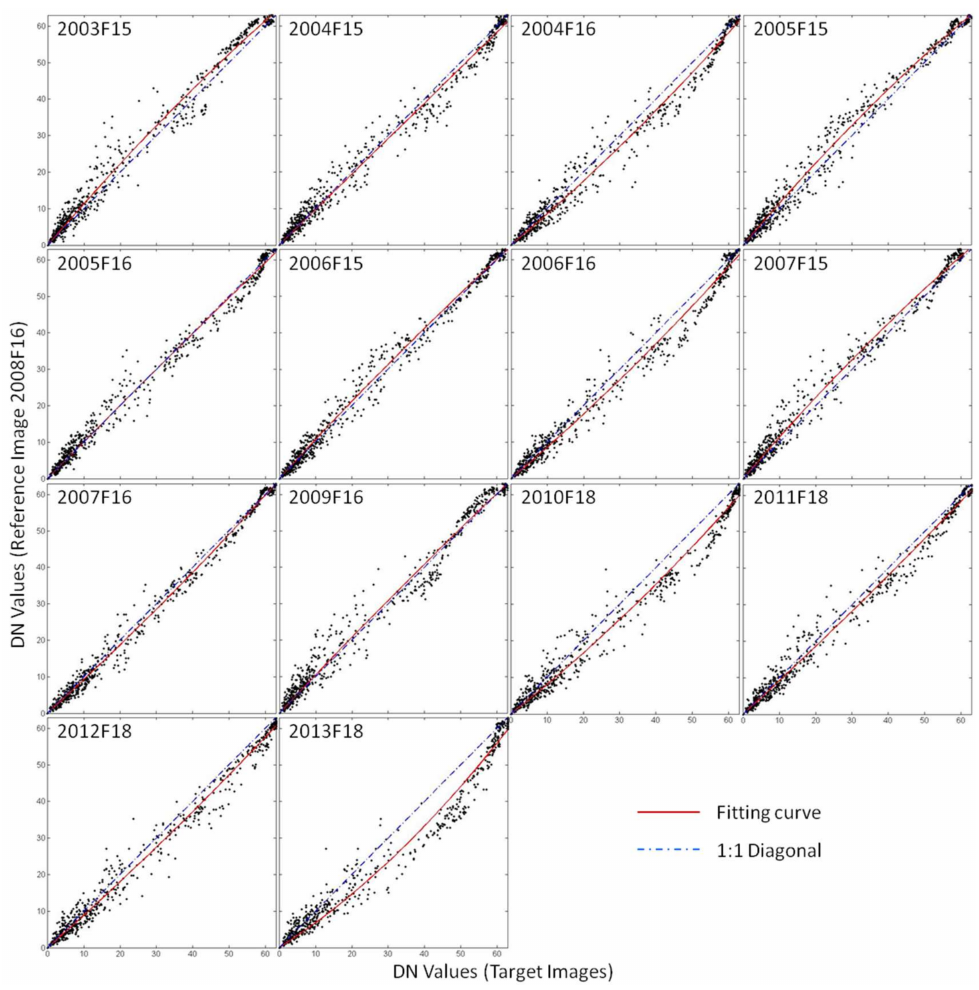
Figure 5. Scatter plots of each target image versus the reference image. The intercalibration was based on 619 lit pixels, which were selected iteratively by twice the standard deviation.